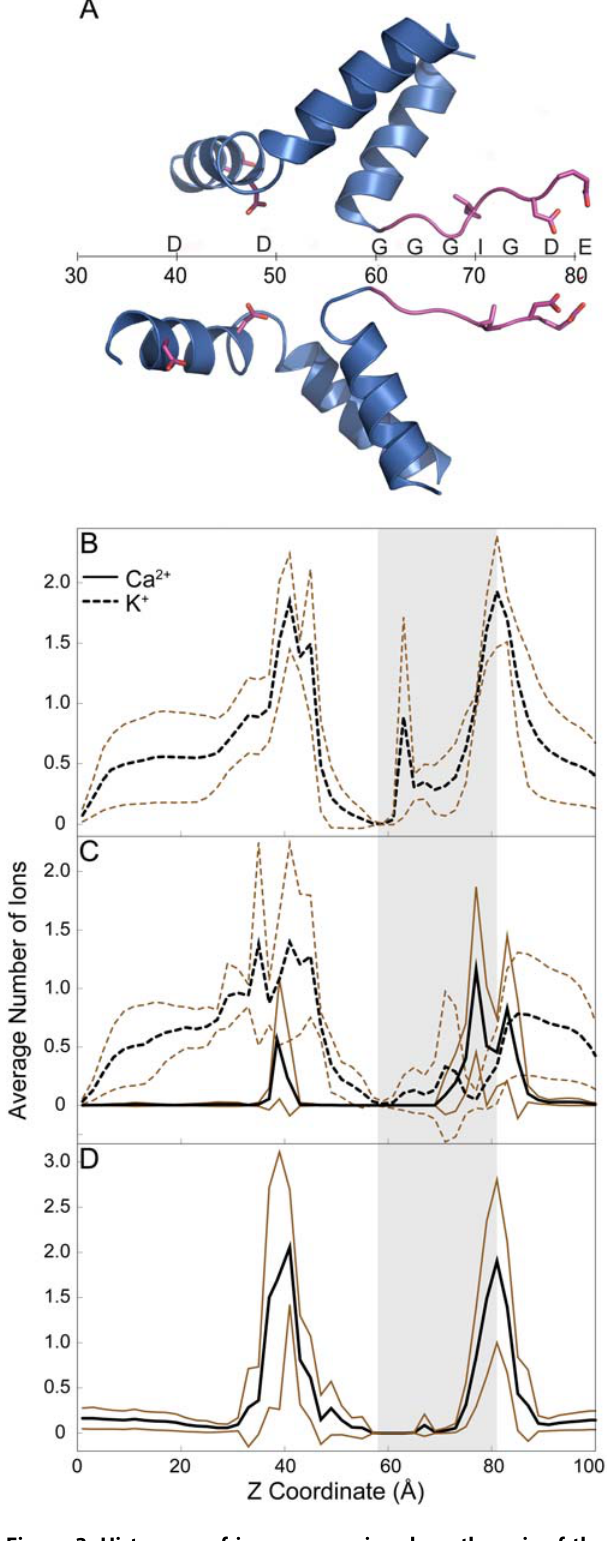
Figure 3. Histogram of ion occupancies along the axis of the channel. (A) Schematic of the pore axis and the positions of residues along the pore axis. (B) RyR1-WT in 250 mM KCl. (C) RyR1-WT in 250 mM KCl and 70 mM CaCl 2 . (D) RyR1-WT with 125 mM CaCl 2 . The region corresponding to selectivity filter is shaded in the plots. This region was determined from the distribution of z coordinates of C a of G4894 and